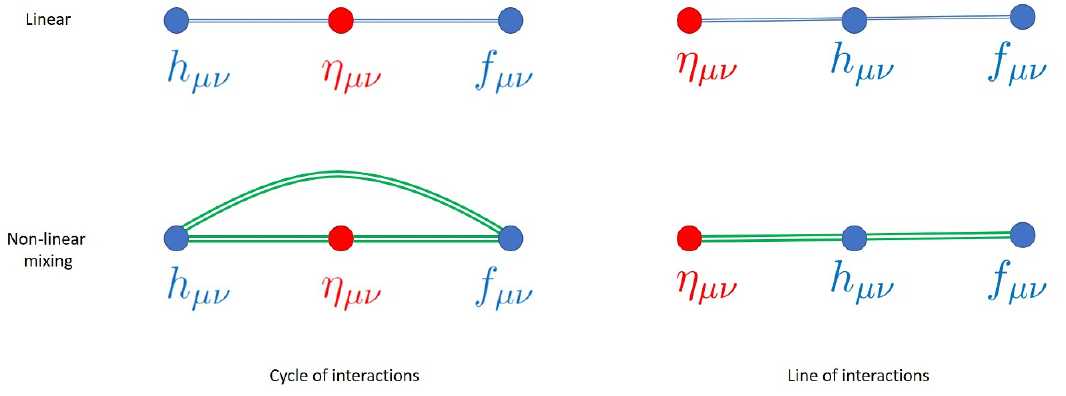
Figure 1 . Di(cid:11)erent interacting topologies [35]. For free (cid:12)elds both models are equivalent (after diagonalization), but the models di(cid:11)er nonlinearly. In terms of the mass eigenstates, the cycle of interactions [left] only includes potential interactions, while the line of interactions [right] also includes a speci(cid:12)c class of kinetic